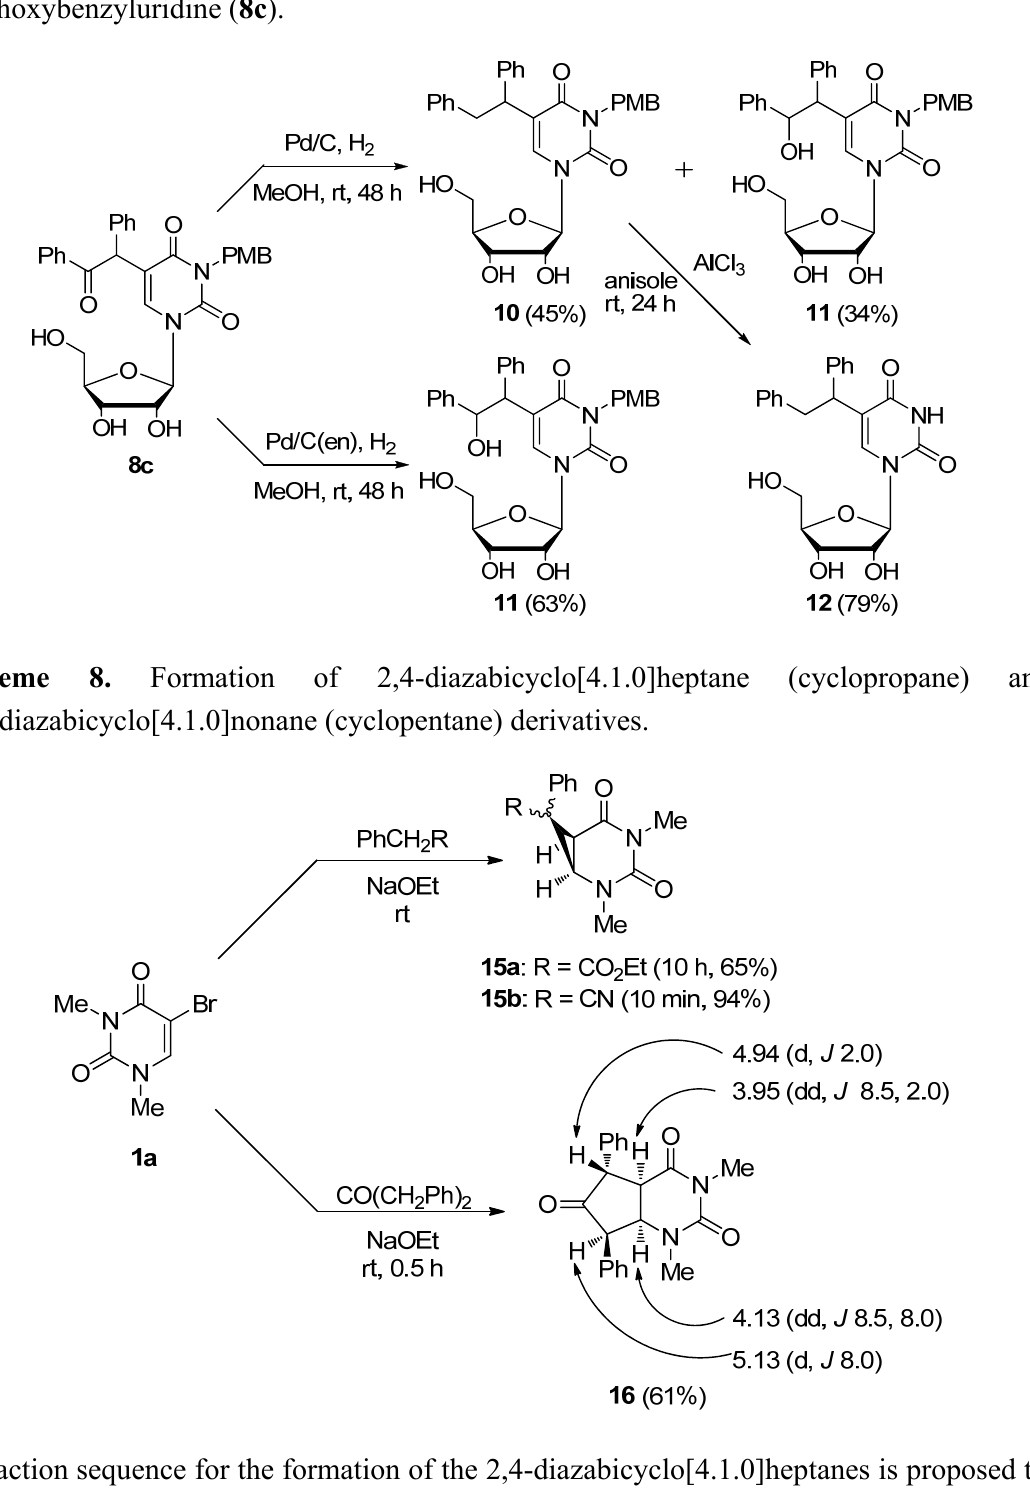
Scheme 7. Pd/C- or Pd/C(en)-catalyzed hydrogenation of 5-( α